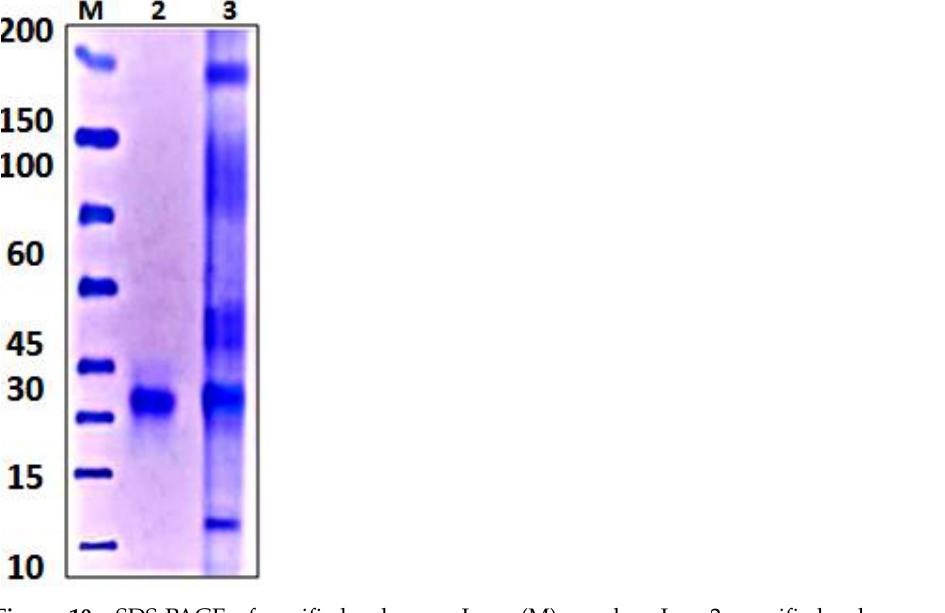
Figure 10. SDS-PAGE of purified xylanase; Lane (M): marker, Lane2: purified xylanase, and Lane 3: crude xylanase.(Protein Ladder, ® Extra broad, molecular weight 6.5 – 270 KDa, Abcam, Waltham, MA, USA).